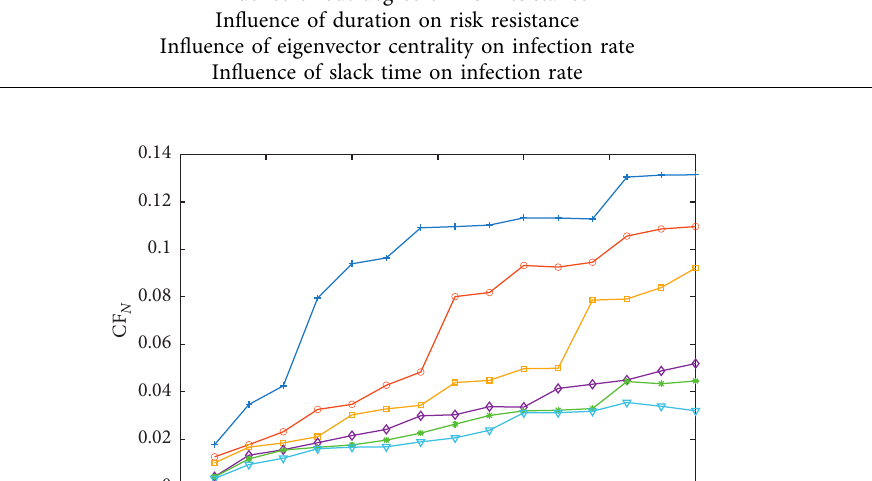
Z ∗ and β E , (b) K , (c) S , and (d) D